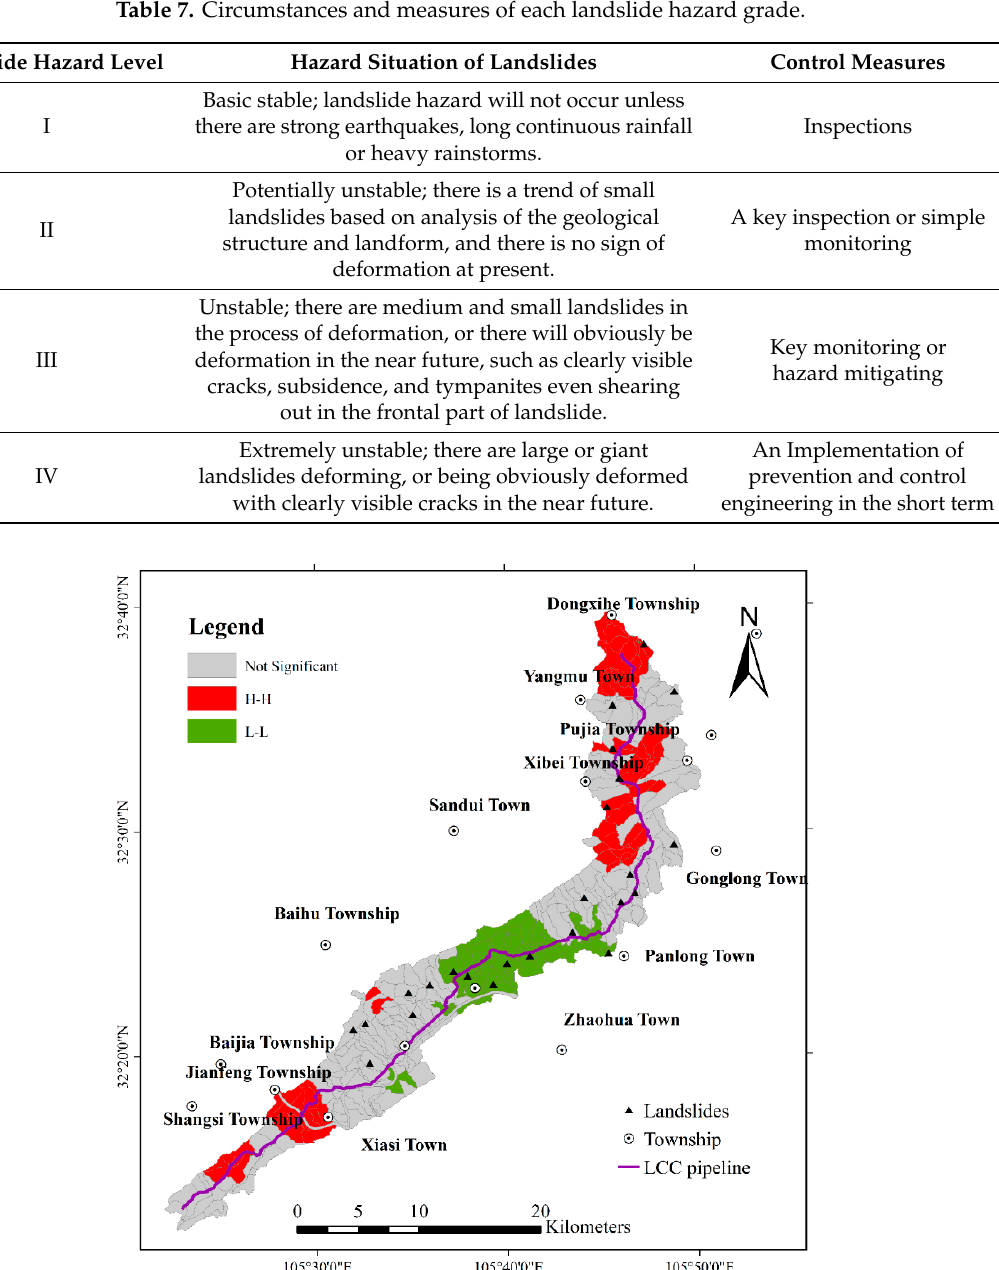
Table 7. Circumstances and measures of each landslide hazard grade.